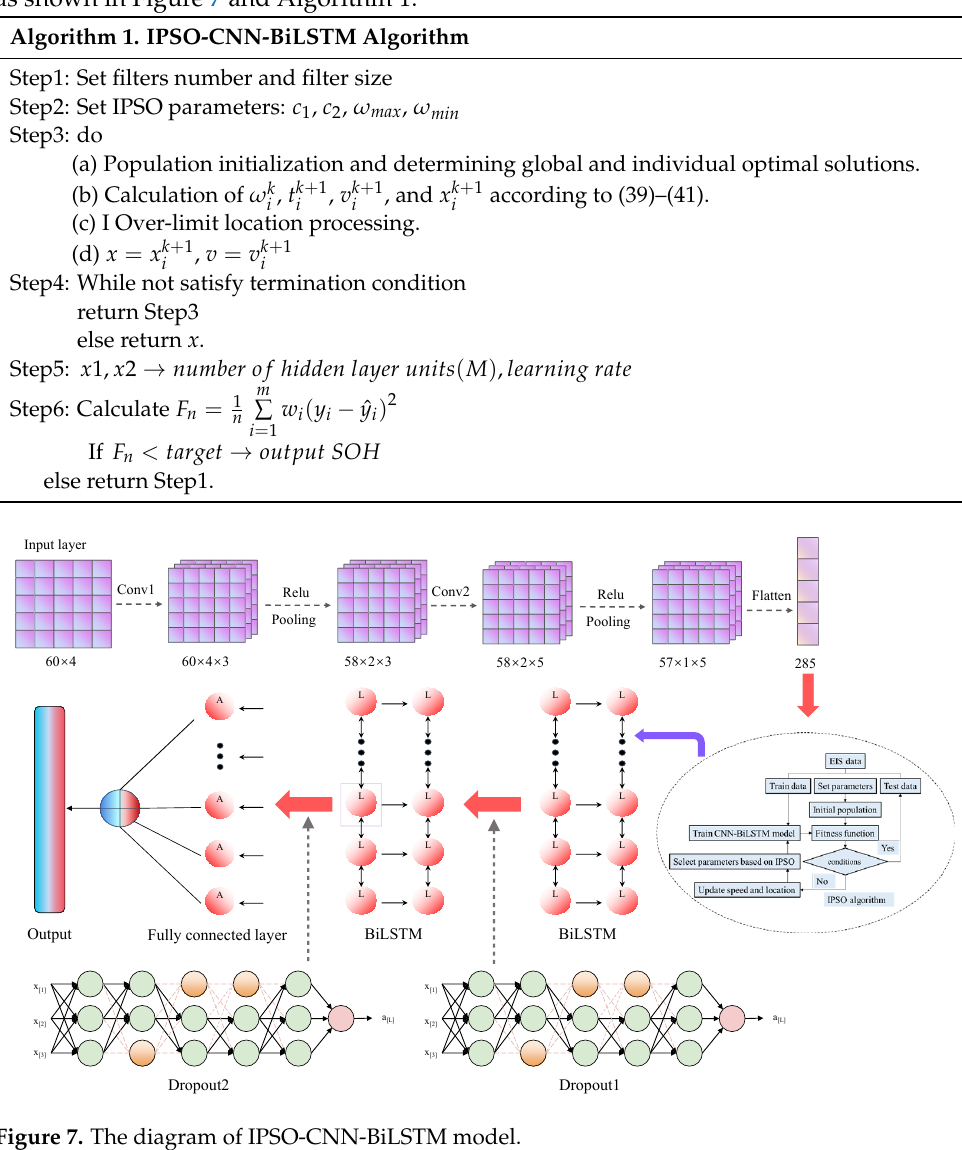
Figure 7. The diagram of IPSO-CNN-BiLSTM model. Algorithm 1. IPSO-CNN-BiLSTM Algorithm